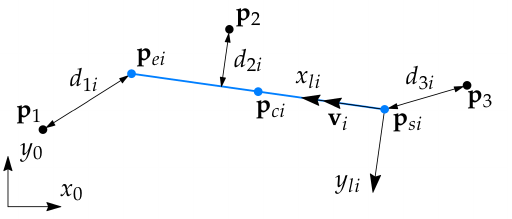
Figure 4. A line segment i is shown in blue color, with three different cases of point-to-segment distances d ji for j = 1,2,3.